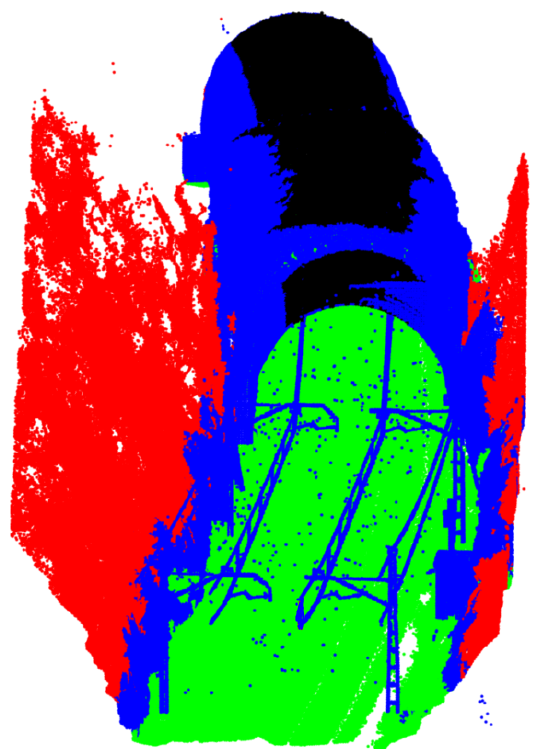
Figure 6. Track segmentation: green voxels are segmented as track; red voxels are segmented as peripherical voxels; dark voxels are segmented as overpass.